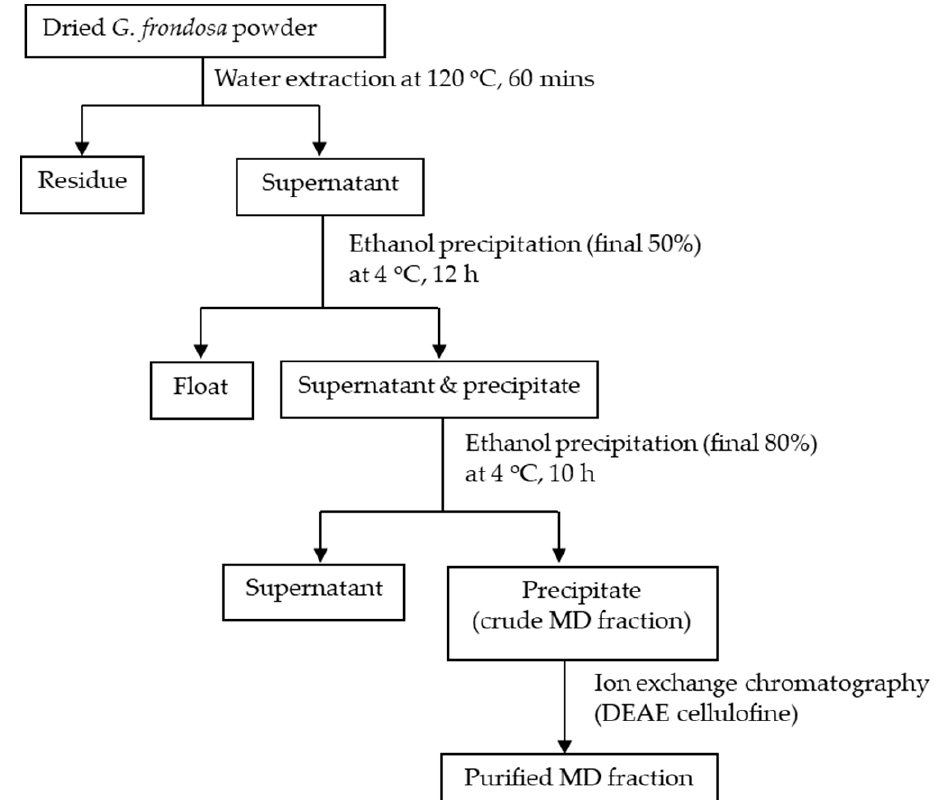
Figure 4. A typical extraction method of the MD fraction from G. frondosa adapted from [50] .